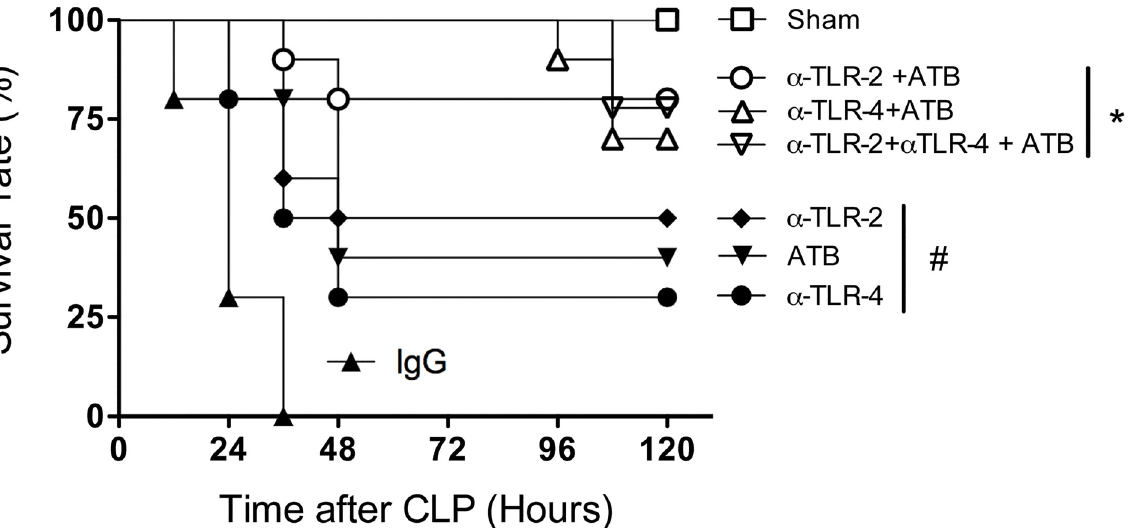
Fig 6. Combined effects of anti-TLR2, anti-TLR4 and antibiotics in polymicrobial sepsis. Mice were therapeutically treated with anti-TLR2, anti-TLR4 and antibiotics (metronidazole and ceftriaxone) separately or concomitantly 3 hours after the CLP procedure. The negative control isotype IgG antibody treatment was used as a control. n = 9 – 10 in each experimental group. * p < 0.001 between use of the antibodies plus antibiotics and isotype IgG control and p < 0.05 between individual use of antibodies or antibiotics. # p < 0.05 between individual antibodies or antibiotics use and isotype IgG control. There was no difference in survival rates between mice given antibodies and antibiotics and the sham group (n = 10 animals/group). Antibody doses (1 mg/animal).